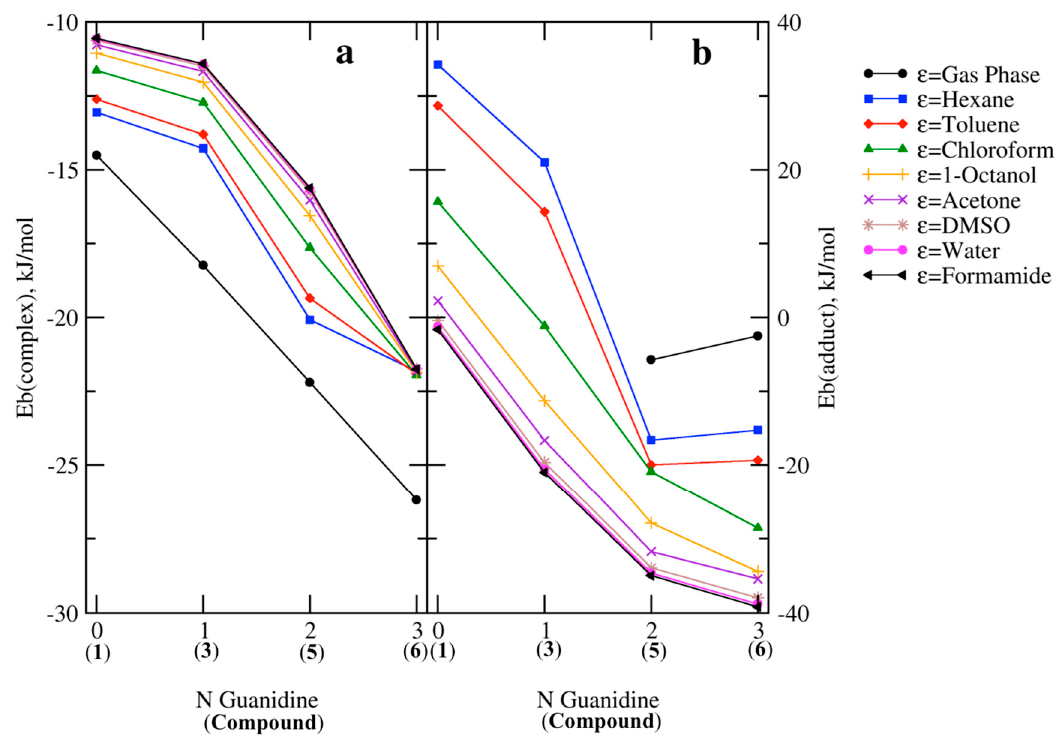
Figure 7. Evolution of the binding energies of the complex ( a ) and adduct ( b ) vs. number or guanidine substituents for systems 1 , 3 , 5 , and 6 .